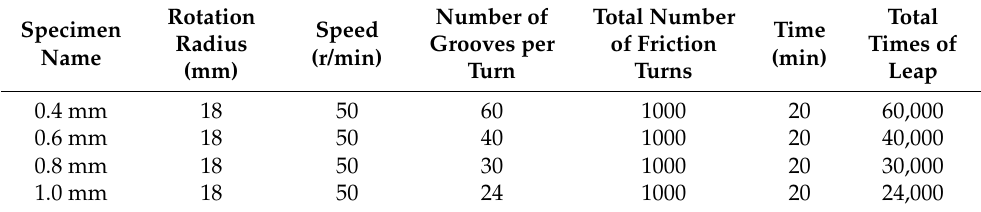
Table 6. Leap parameters for different friction